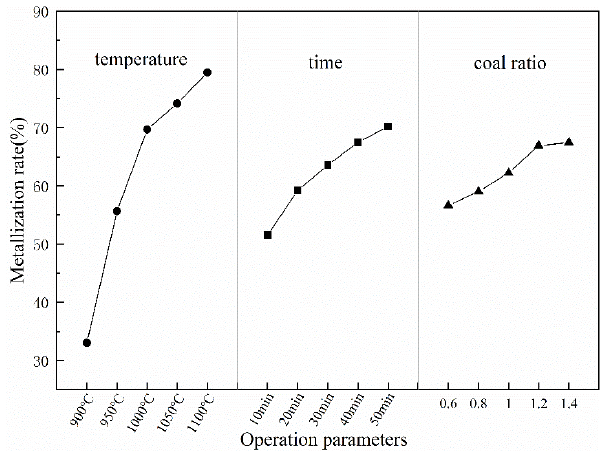
Figure 4. The values of the three selected parameters at the five designated levels for metallization rate of reduced samples.